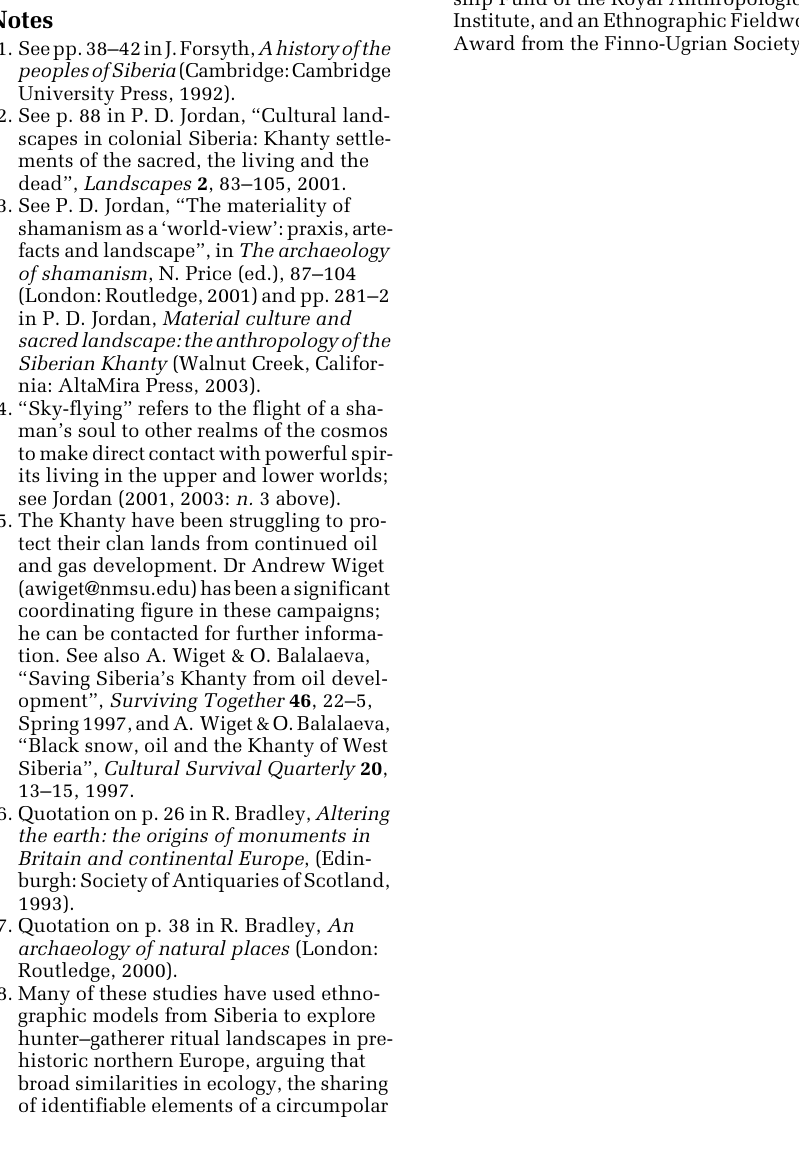
Figure 5 A cache or midden where bones of elk and wild deer have been deposited; tra- ditionally, each household maintained one such midden in the forest at some distance from the yurt